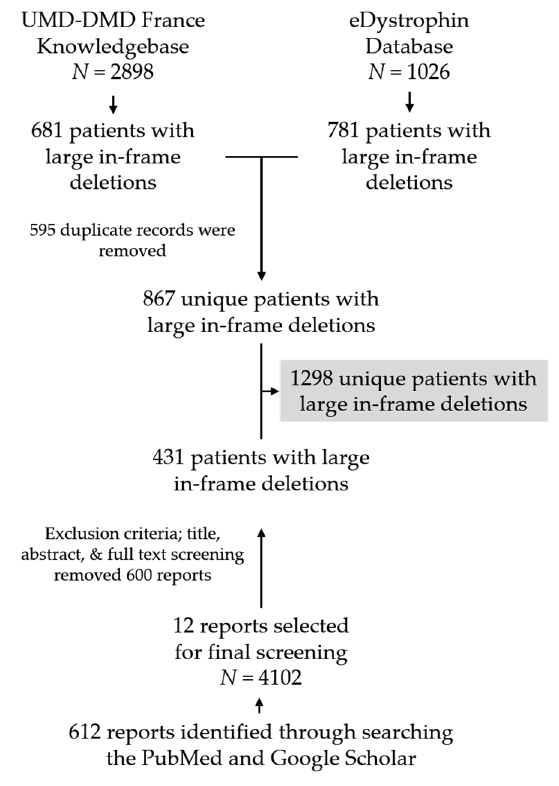
Figure 1. Flow chart showing database screening and literature search procedure to collect patients’ clinical information with confirmed DMD large deletions. N indicates the number of individuals present in each data source.